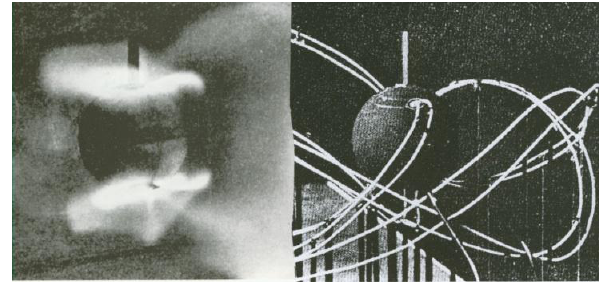
Figure 3. Left: Birkeland’s terrella with the auroral zones simulated as rings of bright optical emissions around both poles when the magnetized sphere is bombarded with energetic electrons. Right: Størmer trajectories of energetic electrons that impact the Earth’s upper atmosphere. Agreement between Birkeland’s laboratory simulations and Størmer’s calculations is excellent.